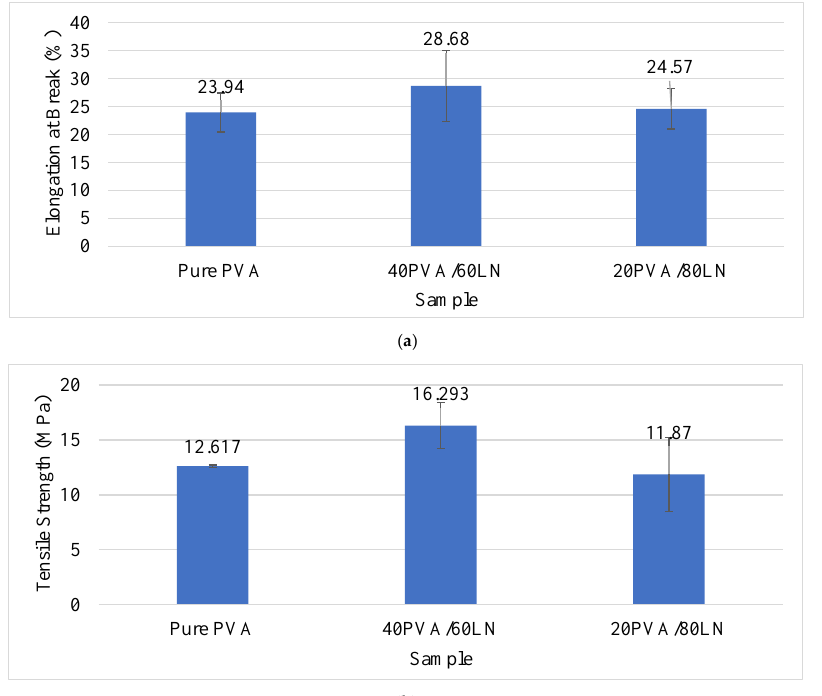
Figure 8. ( a ) Tensile strength and ( b ) elongation at break of PVA and PVA/LN nanocomposite films. Young ’ s modulus values of the neat PVA, 40PVA/60LN, and 20PVA/80LN were 257.77, 208.9, and 140.1 MPa, respectively, as shown in Figure 9. These results indicated that there was no effect of the inclusion of lignin with PVA in both the tensile strength and modulus. However, small lignin particles would reinforce the polymer. Thus, the composite PVA polymer had better mechanical properties. The higher the modulus and tensile strength, the stronger the film [31]. This behavior could be explained by forming strong hydrogen bonds between the lignin and PVA, contributing to the lignin ’ s high surface adhesion and distribution [11]. This resulted in a significant reduction in the transformability of PVA. Additional considerations are that lignin can act as a solid structural component and as a crosslinker in PVA with a linear structure [32].